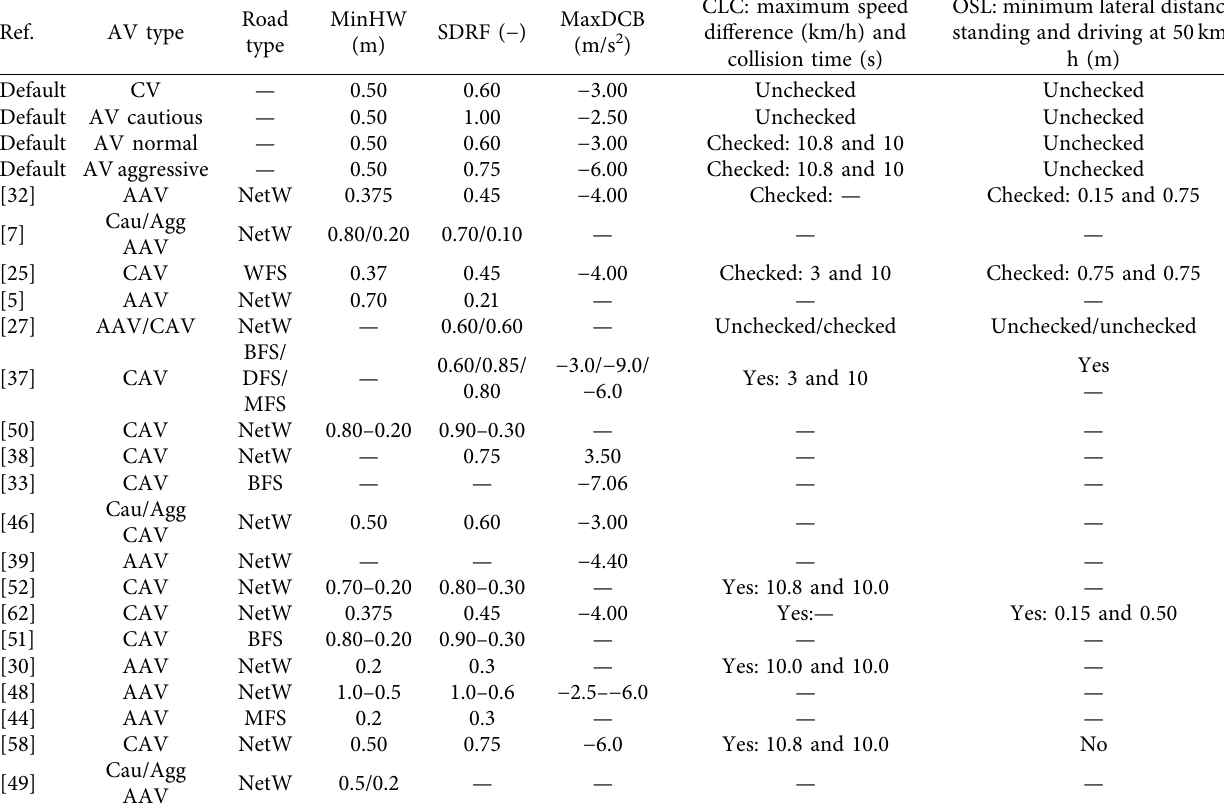
Table 2: Values of lane-changing and lateral behavior parameters calibrated in the literature.